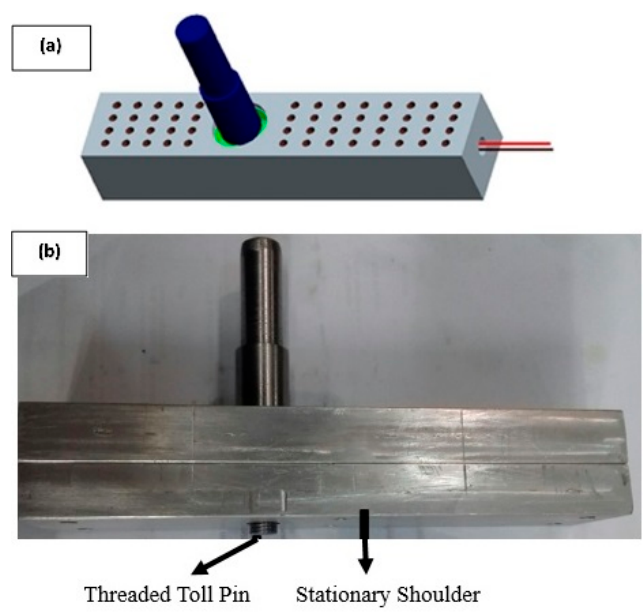
Figure 1. Novel friction stir processing (FSP) tool with holes in the shoe-shaped shoulder ( a ) Schematic and ( b ) Actual tool